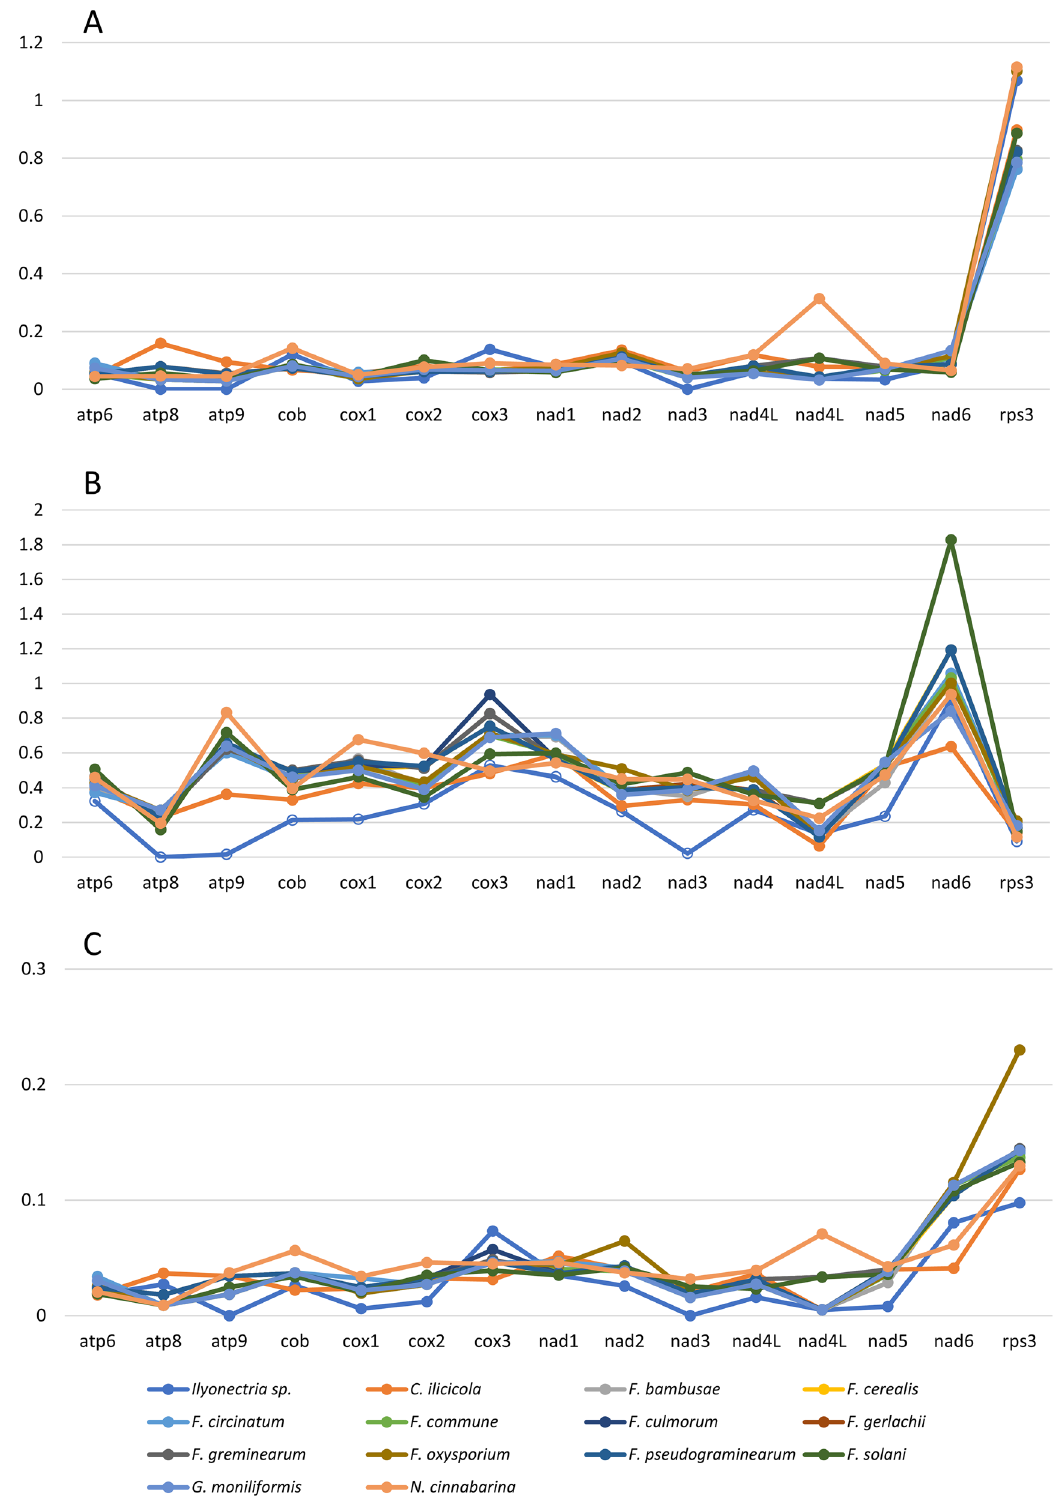
Figure 3. The evolution and dynamic of mitochondrial protein-coding sequences between 15 species representing family Nectriaceae. The mt genome of Ilyonectria destructans was set as a reference. ( A ) Gene specific Ka/Ks ratios; ( B ) Synonymous (Ks) substitution rates; ( C ) Non-synonymous (Ka) substitution